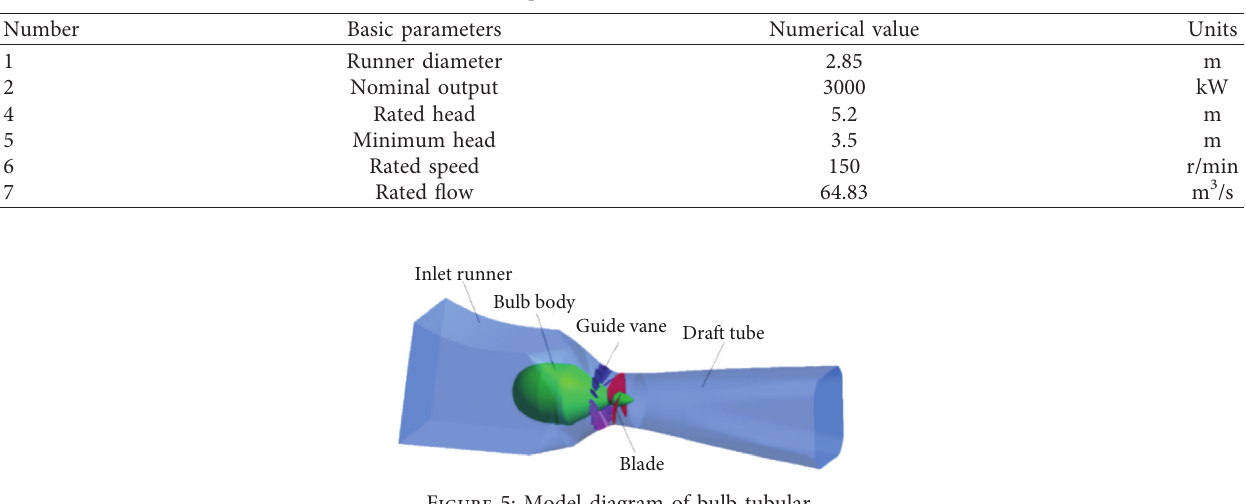
Table 2: Basic parameters of bulb tubular turbine.